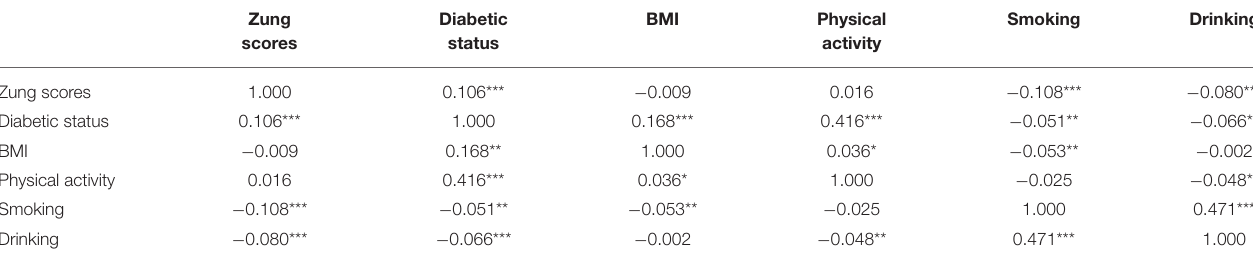
TABLE 2 | Spearman correlation between health conditions, lifestyle factors, and depression.